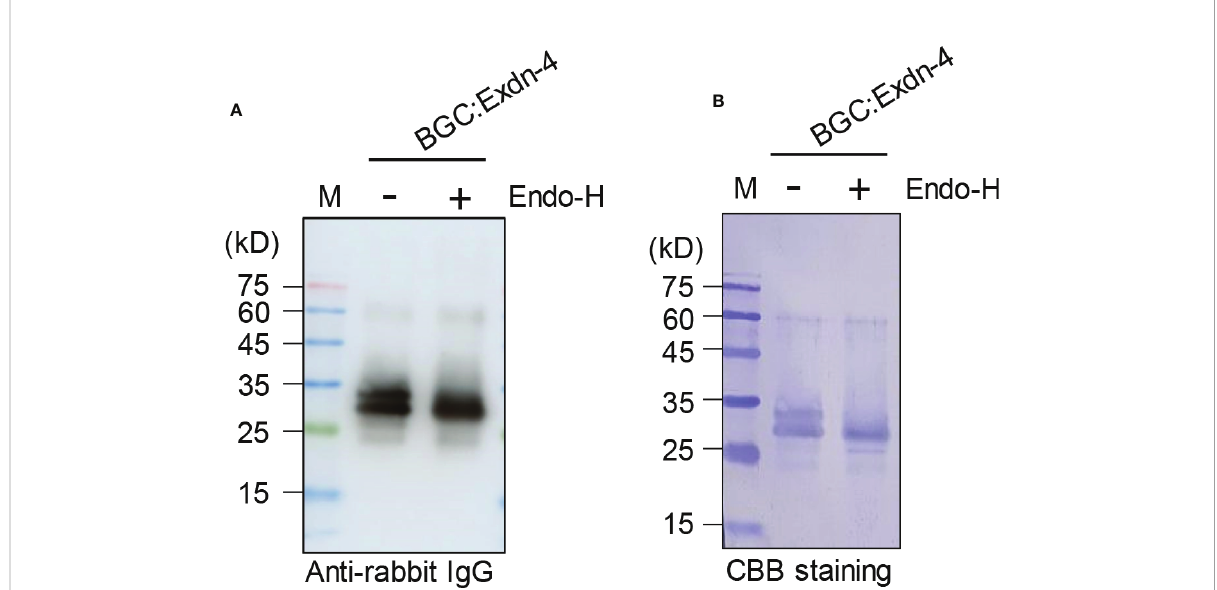
FIGURE 4 A minor proportion of BGC : Exdn-4 is N-glycosylated in N. benthamiana. Puri fi ed BGC : Exdn-4 (2 m g) was denatured by boiling and then incubated with 0.5 units of Endo-H at 37°C for 2 h. Endo-H-treated (+) and untreated (-) BGC : Exdn-4 were separated by SDS/PAGE followed by Western blot analysis (A) or CBB staining (B) . M, protein size